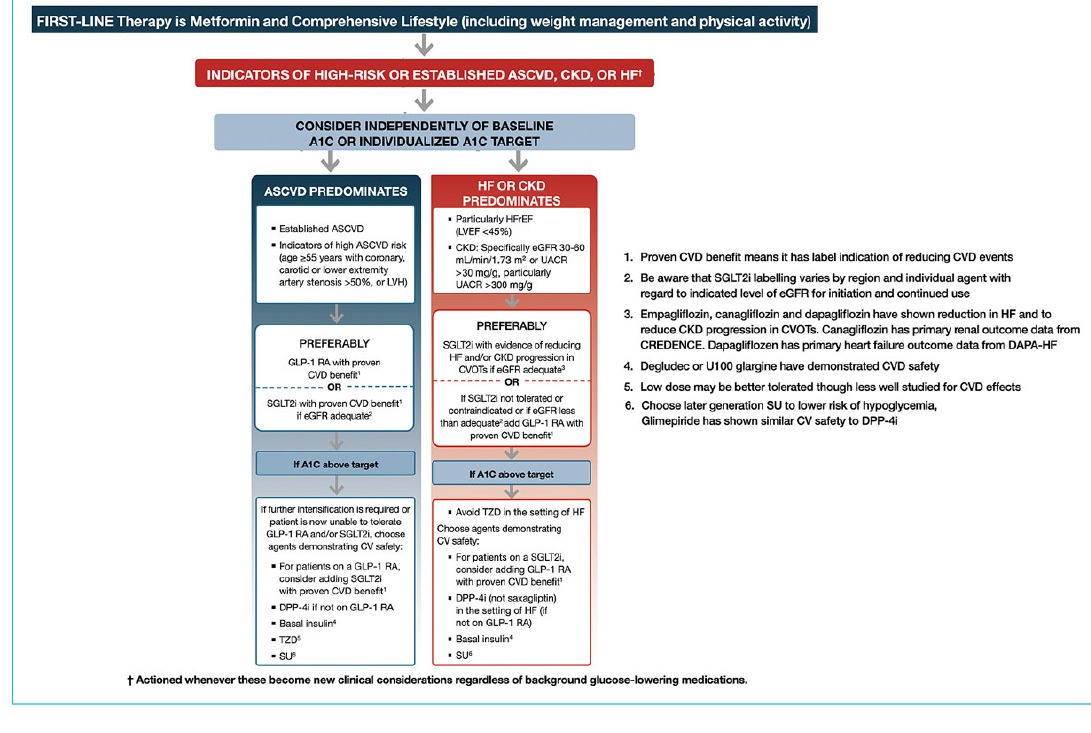
Table 2: Practical aspects of sodium-glucose cotransporter 2 (SGLT2) inhibitor